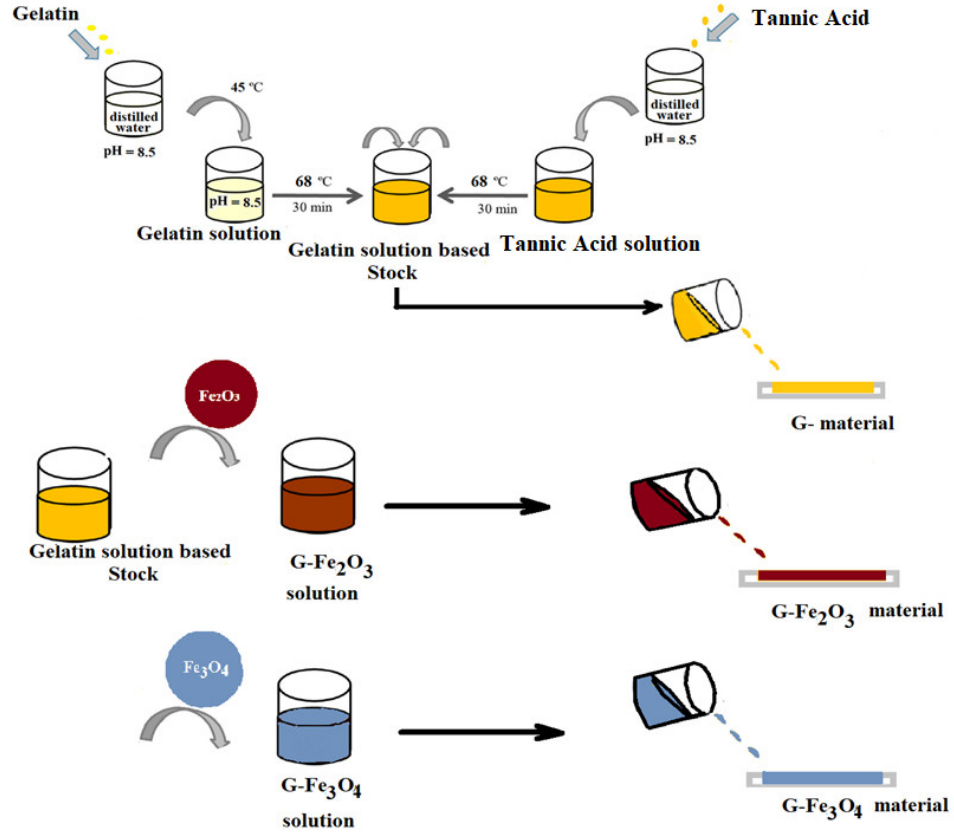
Figure 1. Scheme for obtaining gelatin-based materials embedded with iron oxide